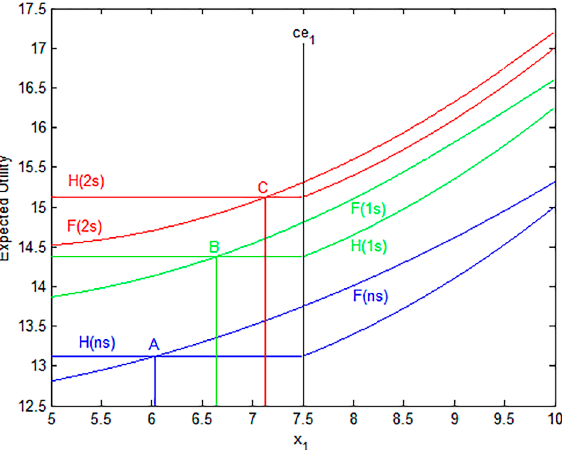
Figure 5. Evolution of thresholds for a risk-neutral DM given uniform beliefs and signals on X